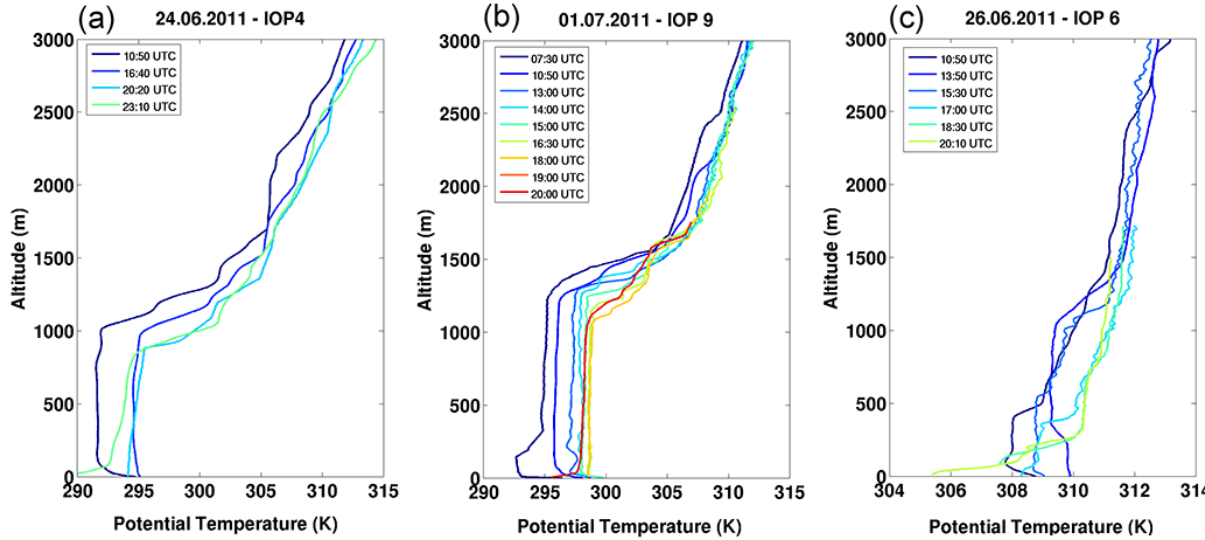
Figure 11. Vertical profiles of potential temperature measured by radiosondes on (a) 24 June, (b) 1 July and (c) 26 June 2011. The launching time is indicated in the top-left corner of each